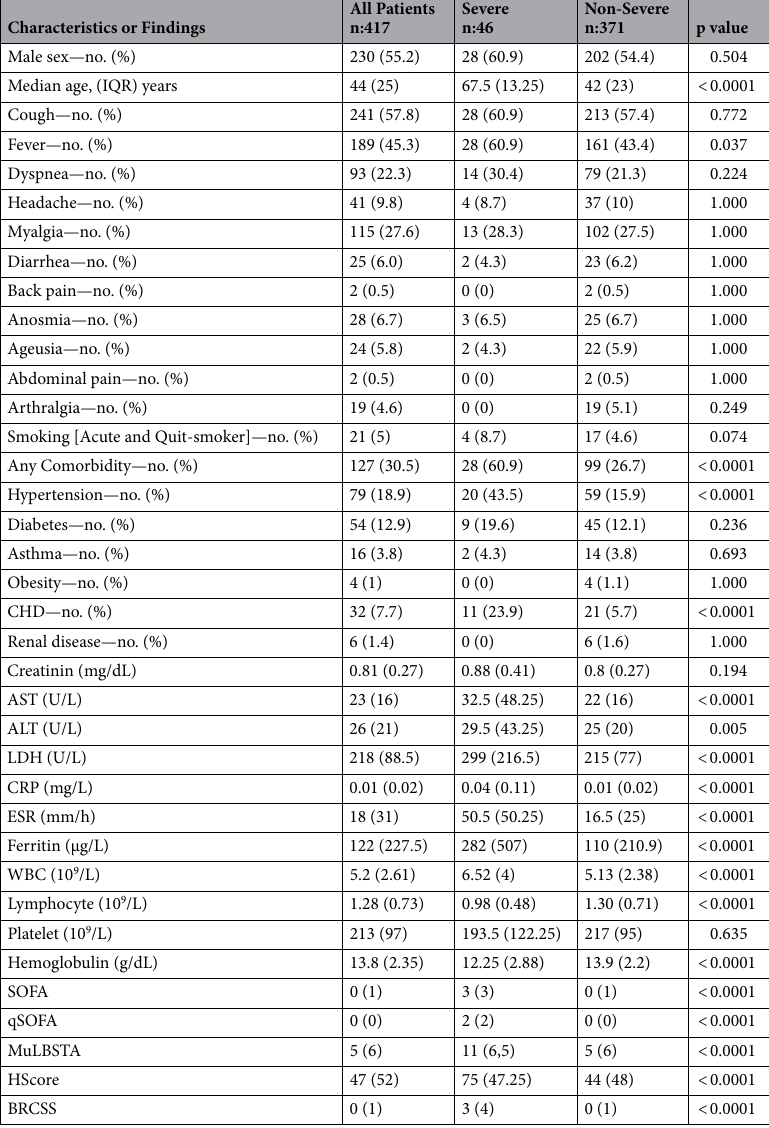
Table 1. Evaluation of the mild and severe patient groups according to clinical status, demographics, past-history, laboratory parameters and scores. All laboratory parameters have been calculated as median (IQR). ESR Erythrocyte sedimentation rate, CRP C-reactive protein, ICU intensive care unit, CHD coronary heart disease, WBC white blood cell count, AST serum aspartate aminotransferase, ALT serum alanine aminotransferase, LDH lactate dehydrogenase, SOFA sequential organ failure assessment score, qSOFA quick sequential organ failure assessment score, MuLBSTA multilobularinfiltration, hypo-lymphocytosis, bacterial coinfection, smoking history, hyper-tension and age score, HScore hemophagocytosis score, BRCSS Brescia respiratory covid severity